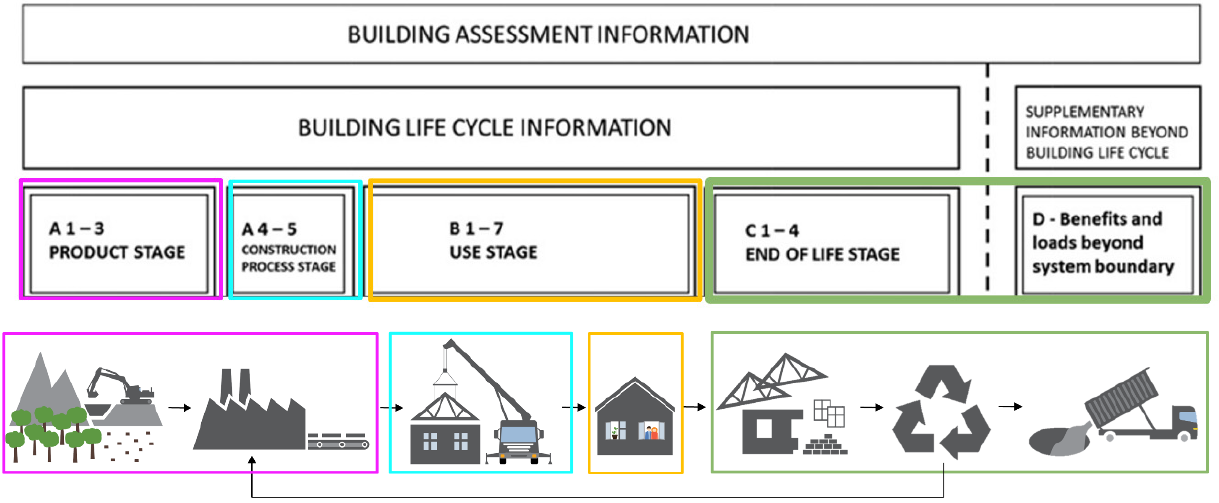
Figure 1. Life cycle stages of a building